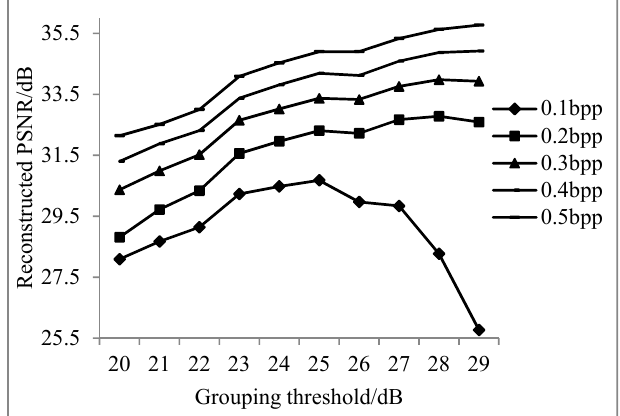
Figure 5. Average reconstructed PSNR of non-key bands for different groups.